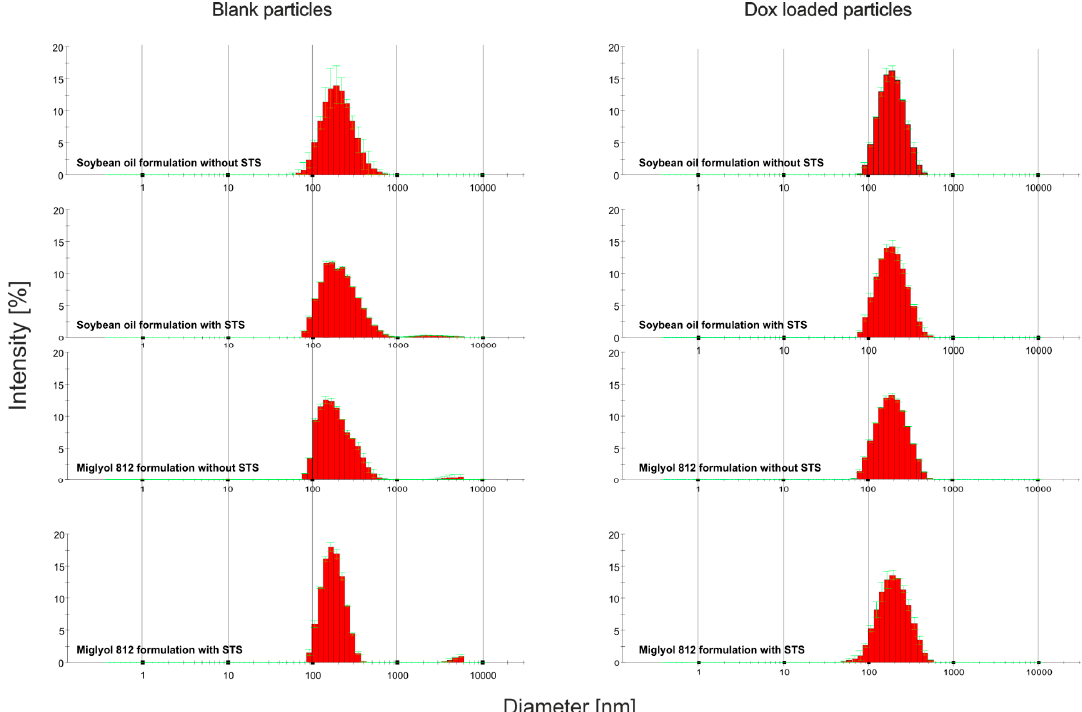
Figure 2. Stable mean hydrodynamic particle size distribution of delivery systems after 7 months of storage at 4 °C in the dark. The same preparations that were measured in Figure 1 were stored for 7 months in the dark at 4 °C and subjected to a determination of the mean hydrodynamic particle size distribution, as described in Figure 1 and above. The distribution of the hydrodynamic particle size (in nm) is plotted against the intensity (in %). Individual preparations are denoted on the left side of each graph.